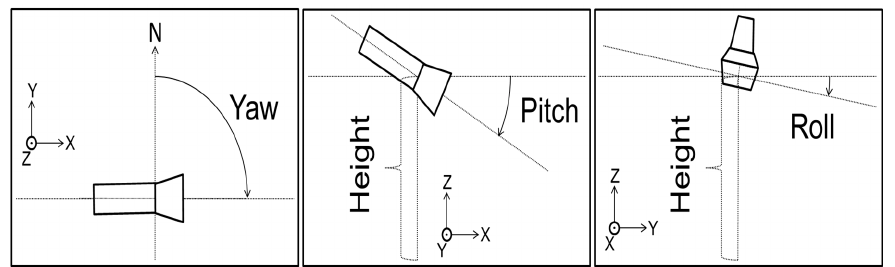
Figure 5. Camera orientation parameters defining the viewing geometry. Table 1. Orthorectification parameters for the